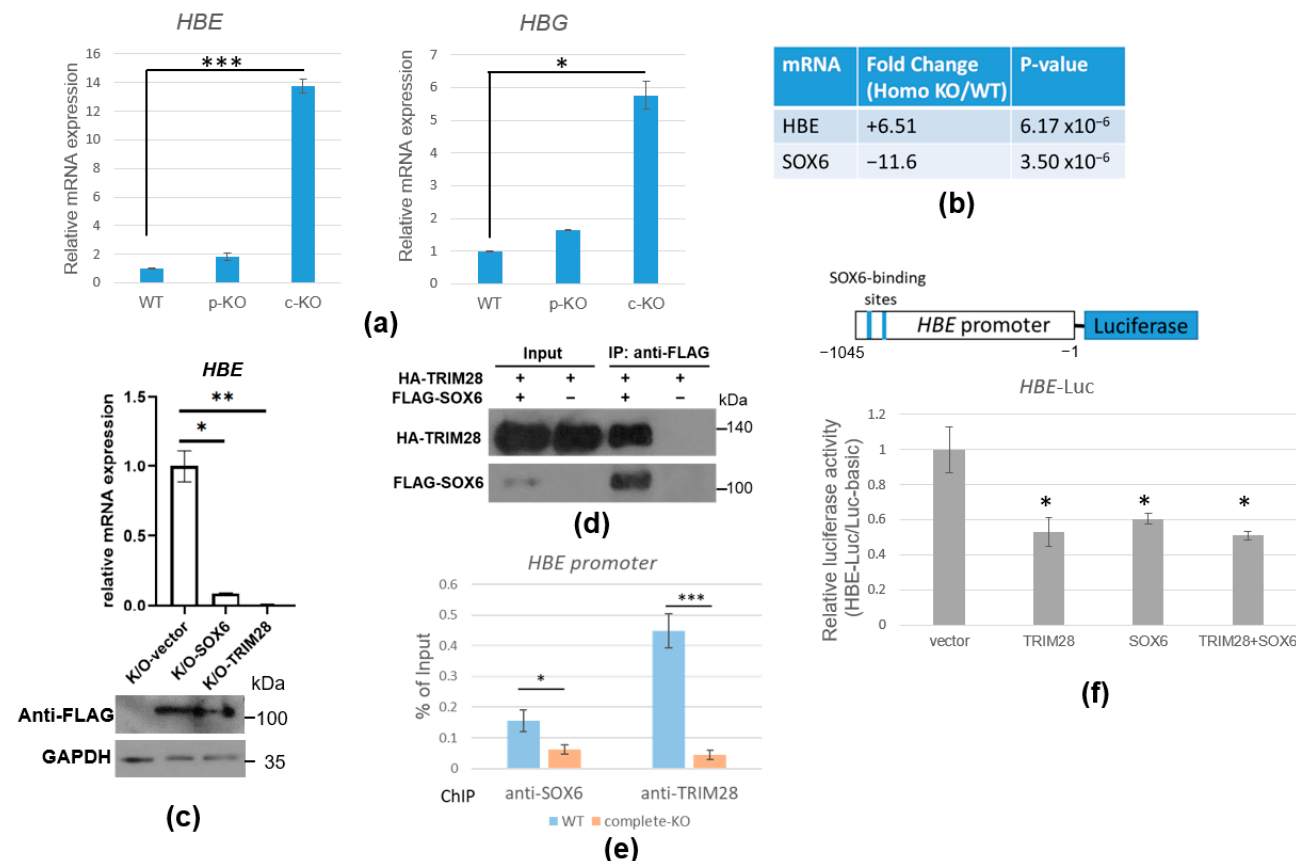
Figure 7. TRIM28 regulates HBE mRNA expression via SOX6 transcription repressor. ( a ) RT-qPCR analysis. RNAs from WT, TRIM28 partial-KO, and complete-KO K562 cells were subjected to RT-qPCR with HBE , HBG , and GAPDH primers. ( b ) The HBE and SOX6 mRNA expression in microarray analysis. ( c ) The rescue analysis. The TRIM28 complete-KO K562 cells were transfected with FLAG-SOX6 or FLAG-Trim28. After drug selection, RNAs were isolated for RT-qPCR analyses with HBE cDNA primers (upper panel) and whole-cell extracts were Western blotted with indicated antibodies (lower panel). ( d ) Co-IP of TRIM28 and SOX6. The FLAG-SOX6 and HA-TRIM28 expression plasmids were transfected as indicated into HEK293T cells. The whole-cell extracts were IPed with anti-FLAG and Western blotting with anti-HA and anti-FLAG. ( e ) ChIP assay. The WT, partial-KO, and complete-KO cells were fixed by formaldehyde and IPed with anti-TRIM28 or anti-SOX6. The precipitated genomic DNA was qPCR analyzed with HBE promoter primers. ( f ) Luciferase assay. The HBE promoter-driven luciferase expression vector was co-transfected with FLAG-SOX6, HA-TRIM28, or FLAG-SOX6 and HA-TRIM28 together and then luciferase activity was measured. All experiments were independently repeated three times, and * p < 0.05, ** p < 0.01, and *** p < 0.001.